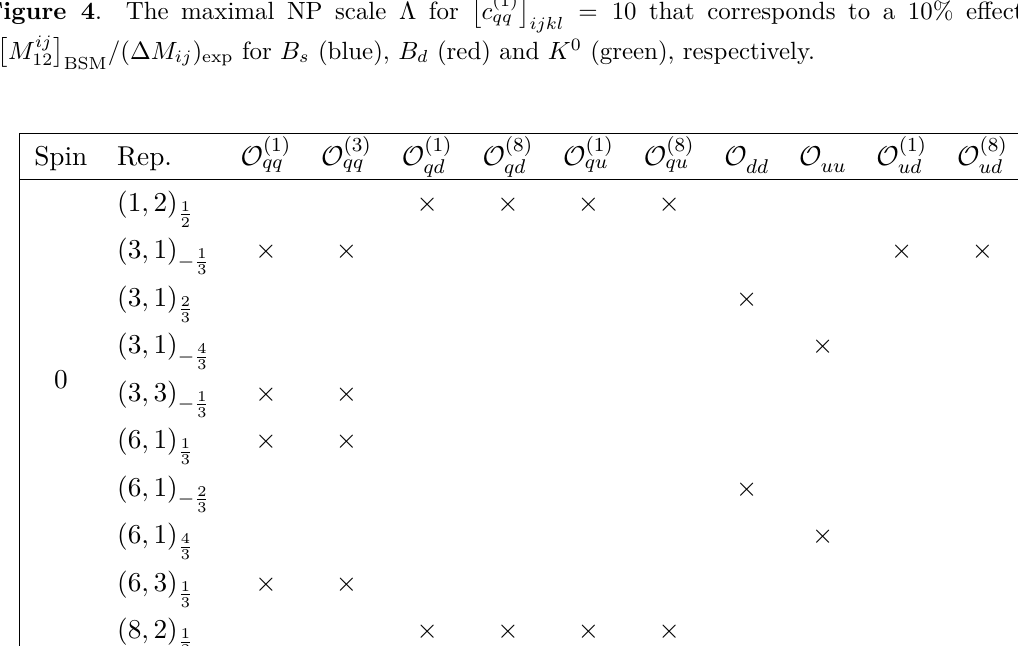
Table 5 . Four-quark ( ψ 4 ) operators generated from additional scalar